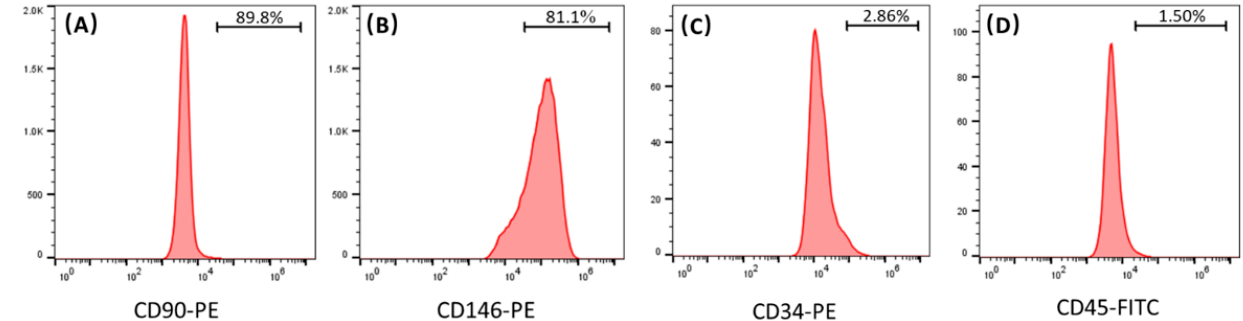
Figure 1. Immunophenotyping of hPDLSCs by flow cytometry. ( A , B ) present that the cells highly expressed MSC surface marker (CD105 and CD146). ( C , D ) show that cells were negative for hematopoietic markers (CD34 and CD45).